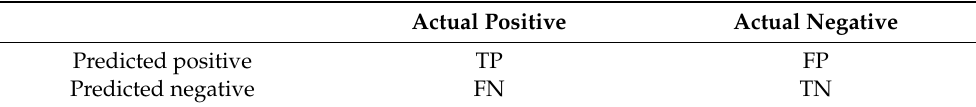
Table 3. Confusion matrix.